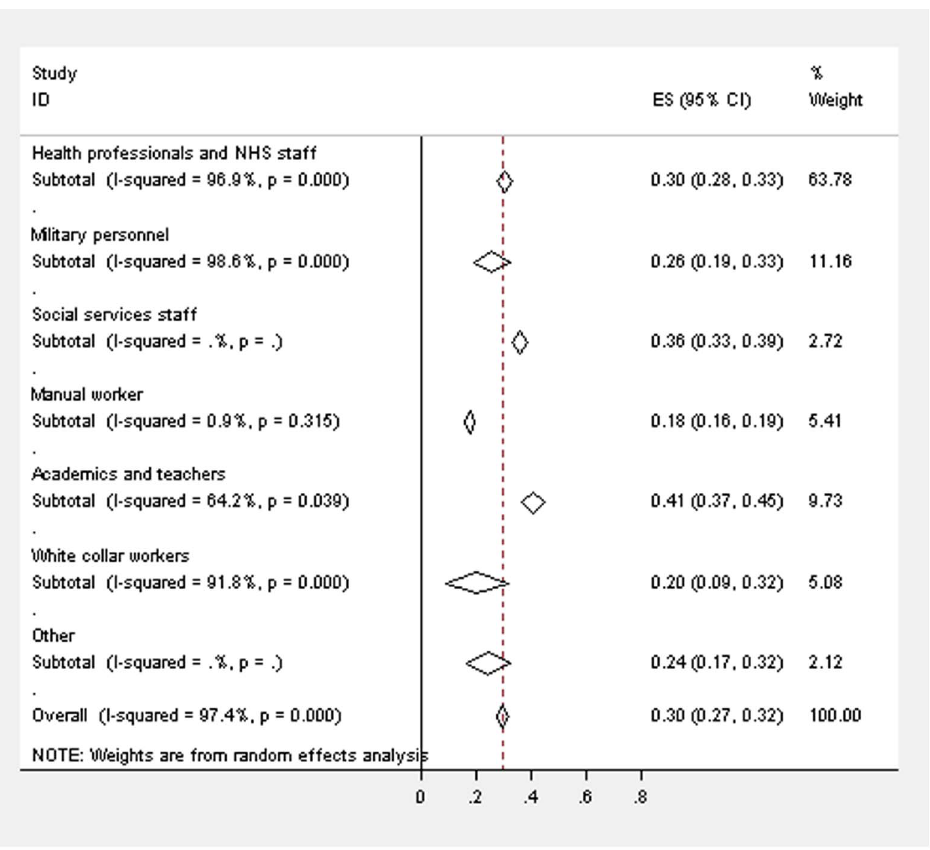
Figure 3. Forest plot displaying the weighted estimates for CMD caseness across the occupational groups (restricted to studies using GHQ-12 (3/4)).